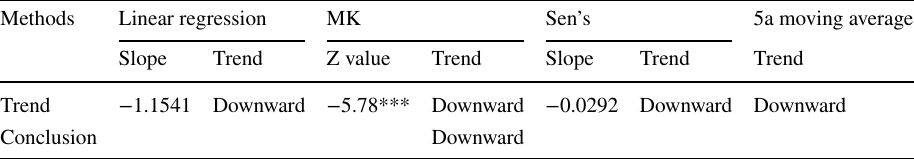
results of runoff series in Huangfuchuan River